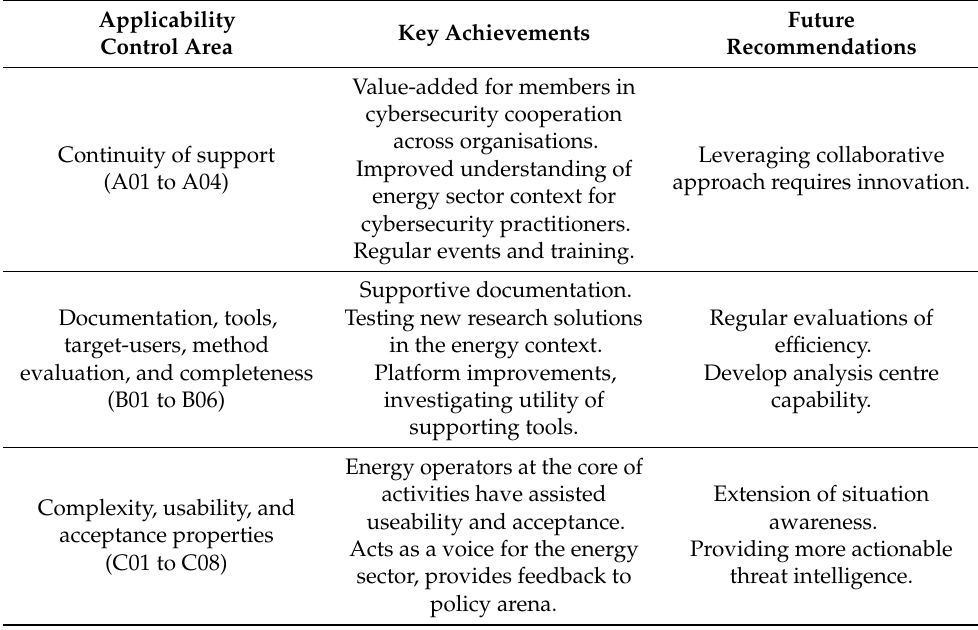
Table 4. Key achievements and future recommendations for the